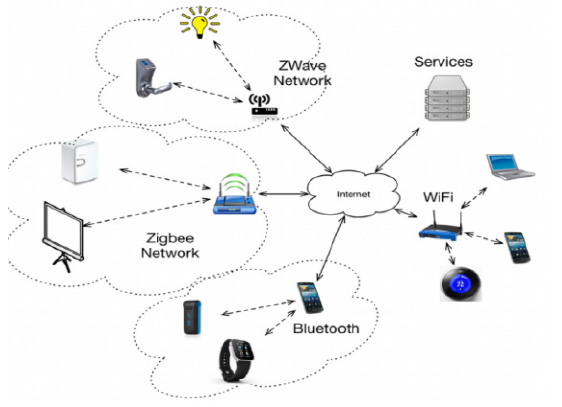
Fig. 1: IoT Network